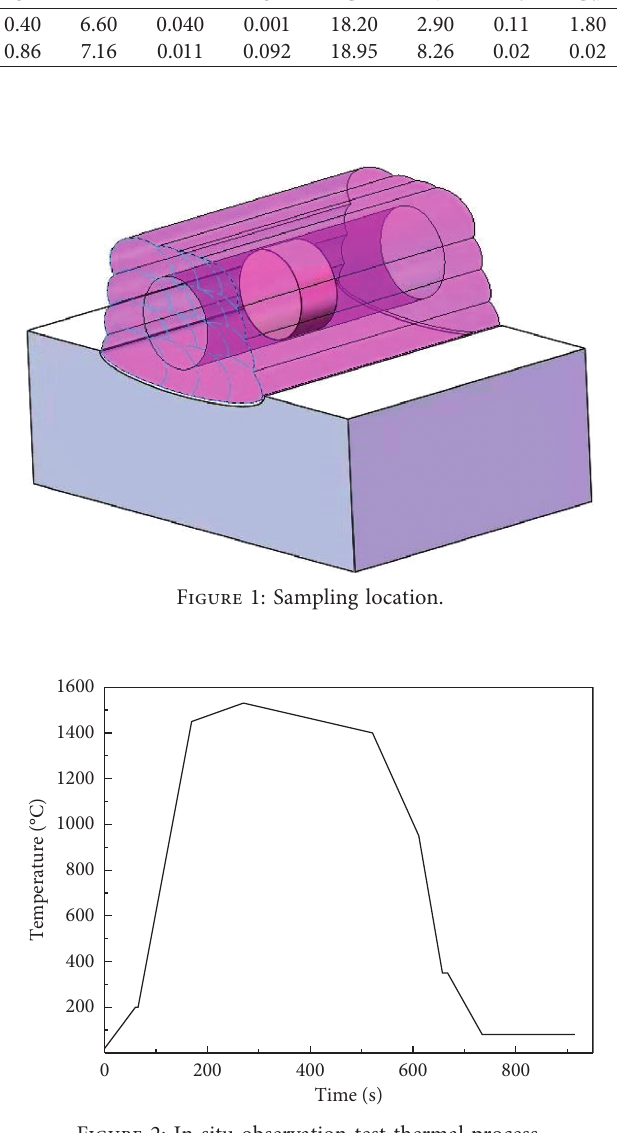
Figure 2: In situ observation test thermal